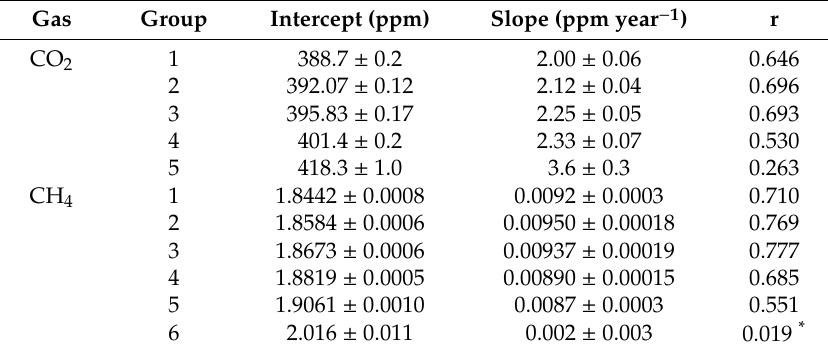
Table 1. Linear trend parameters and their uncertainty (5% level) for groups of percentiles.